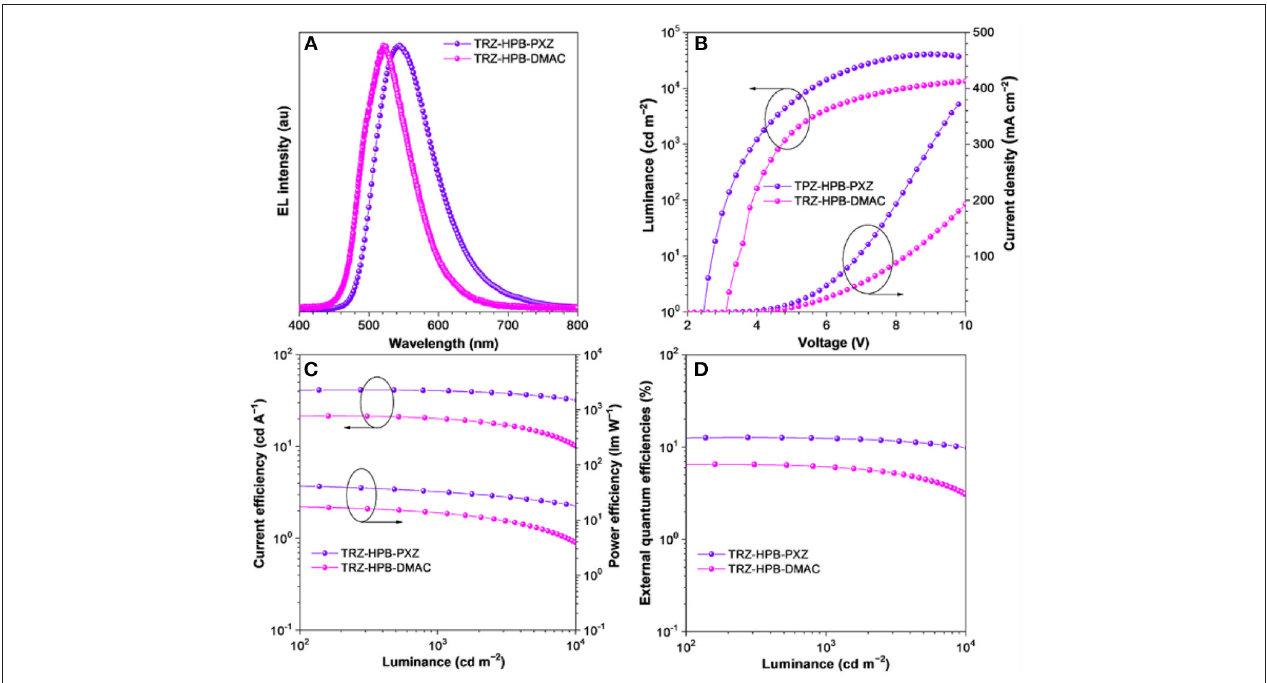
FIGURE 5 | (A) EL spectra at luminance of 1,000cd m − 2 , and characteristic curves of (B) luminance-voltage-current density, (C) current efficiency-luminance-power efficiency, and (D) external quantum efficiency-luminance of the non-doped OLEDs.